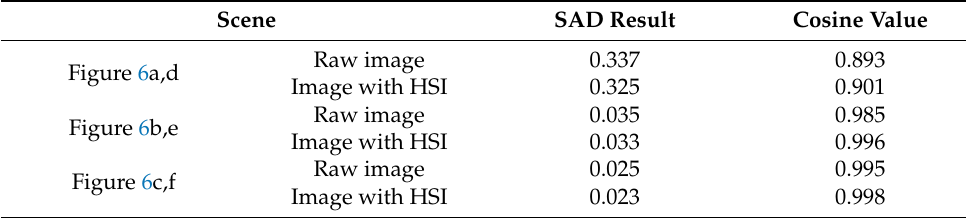
Table 3. Comparison of SAD results and cosine similarity before and after system improvement.